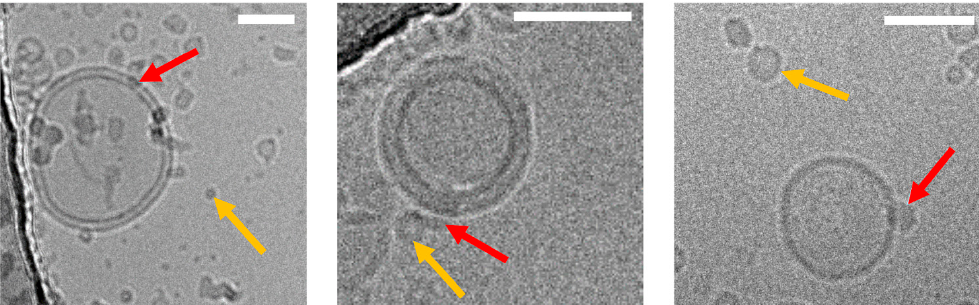
Figure 2. Cryo-EM images of lipoprotein particles fused to an artificial membrane mimicking the plasma membrane (unpublished data, J. Novacek). ( Left to right ): images of HDL, LDL, and VLDL particles fused (red arrow) to individual large unilamellar vesicles (LUV) made from 1,2-dioleoyl-sn-glycero-3-phosphocholine (DOPC). Non-fused lipoprotein particles are exemplarily indicated by the yellow arrow. Lipoprotein particle incorporation into the LUV membranes was confirmed through recording data under different electron-beam incident angles (0°, 30°, 60°, not shown), thus excluding an accidental overlay of signals originating from different layers of the vitrified ice. Images were acquired under low-dose conditions (20 e/Å 2 ). Scale bars are 50 nm.